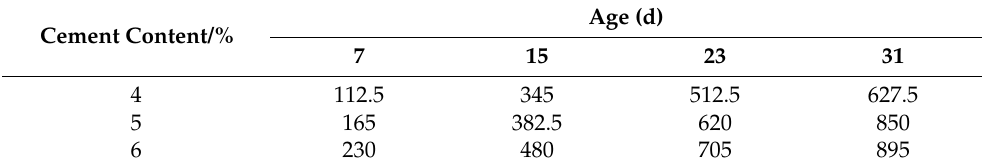
Table 13. Dry shrinkage strain value of cement stabilized gangue (×10 − 6 ).